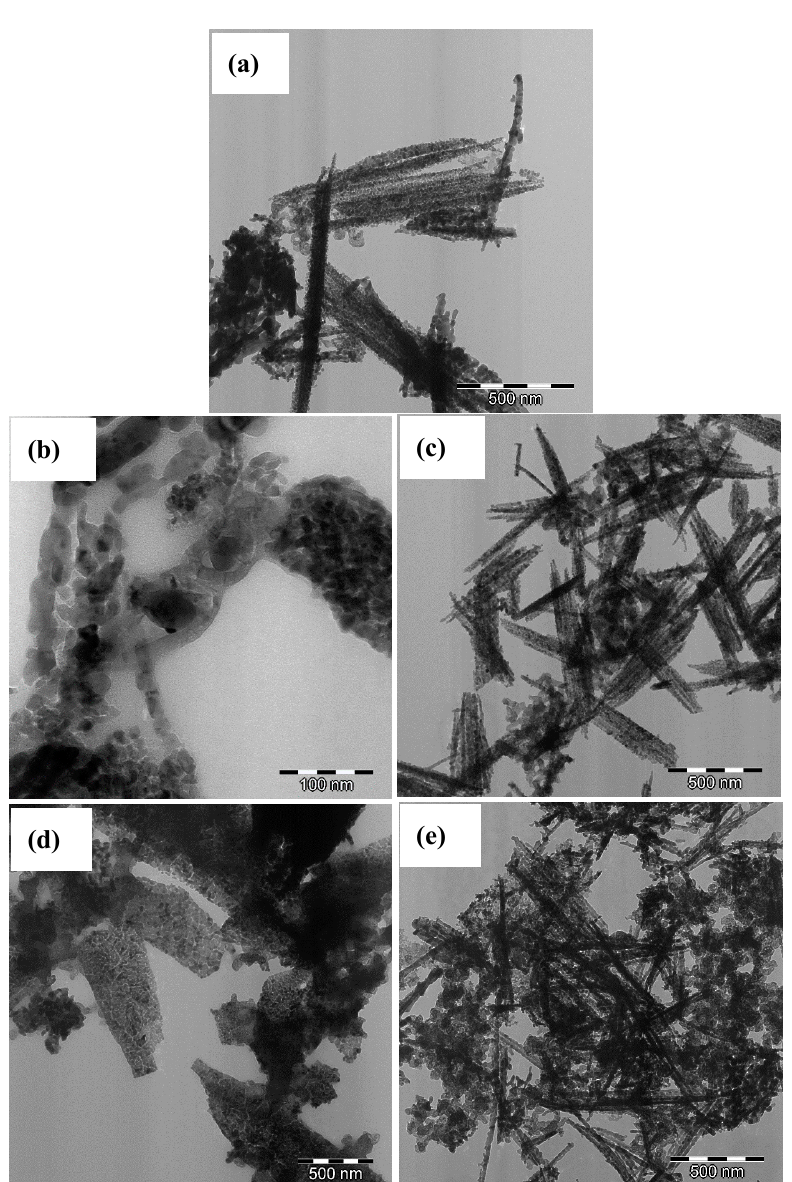
Figure 4. TEM images for ( a ) NiCo 2 O 4 / Co–CX, ( b ) NiCo 2 O 4 / Ni–CX, ( c ) NiCo 2 O 4 / Fe–CX, ( d ) ZnCo 2 O 4